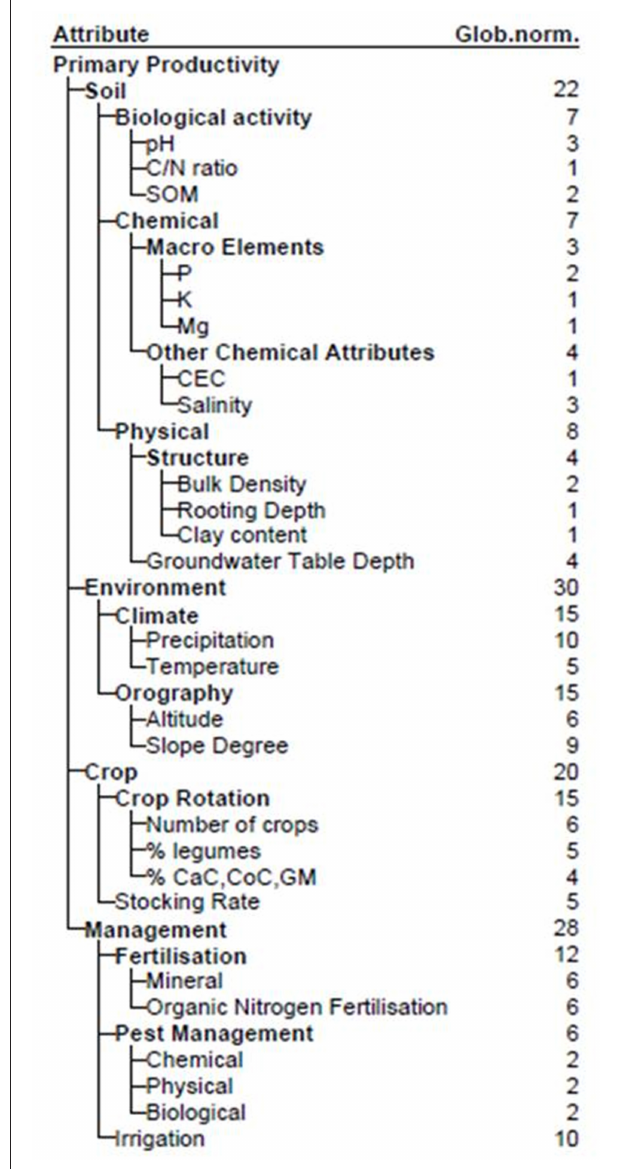
FIGURE 3 | Importance of attributes in the primary productivity model. Importance is expressed in percentage representing the contribution (ratio) of attribute’s variability in outcome’s variability. Hence, subconcepts (attributes at first level in the hierarchical structure) soil, environment, crop, and management contribute 22, 30, 20, and 28%, respectively, to the primary productivity